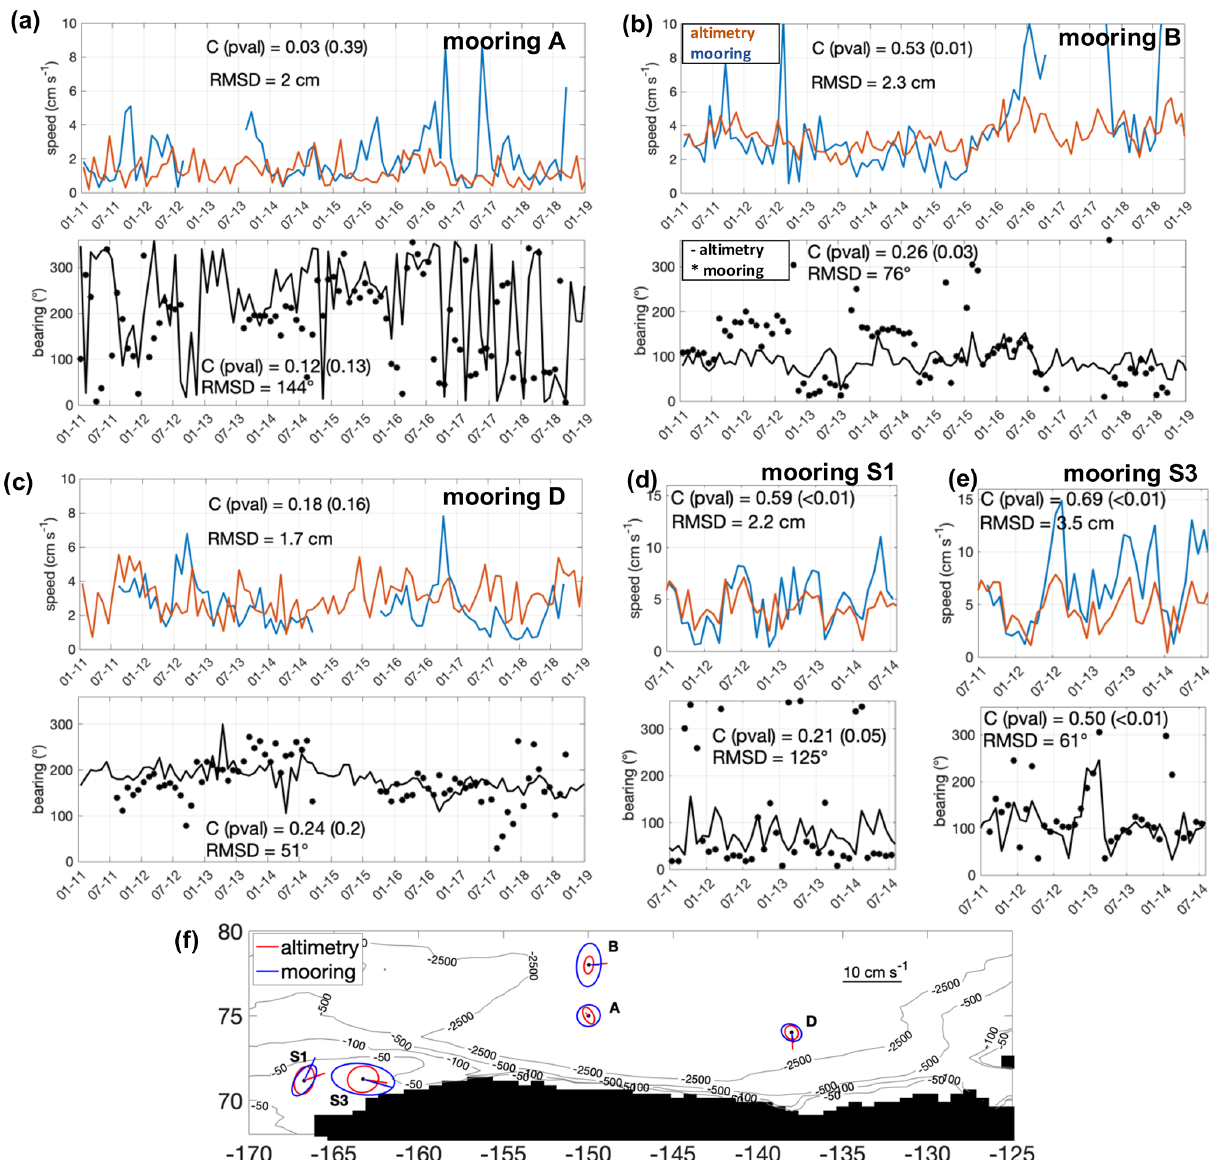
Figure 13. The altimetry-derived currents’ speed and bearing are shown against the in situ measured ones at moorings A (a) , B (b) and D (c) in the Beaufort Sea and moorings S1 (d) and S3 (e) in the Chukchi Sea (see Fig. 1). (f) Mean currents and variance ellipses at each